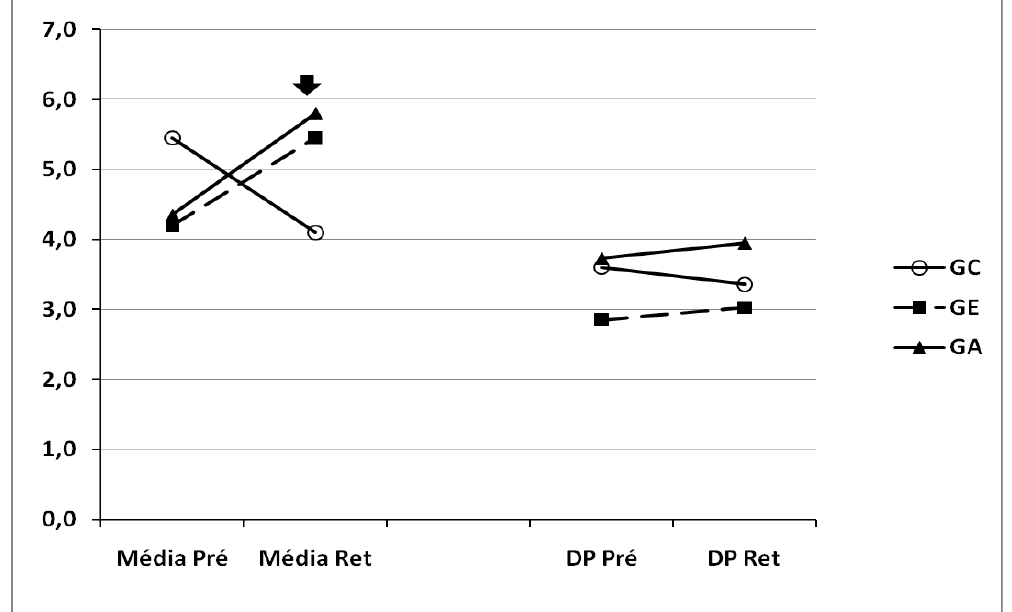
Figura 3. Média e Desvio-padrão do escore de cada grupo durante o pré-teste e teste de retenção. A